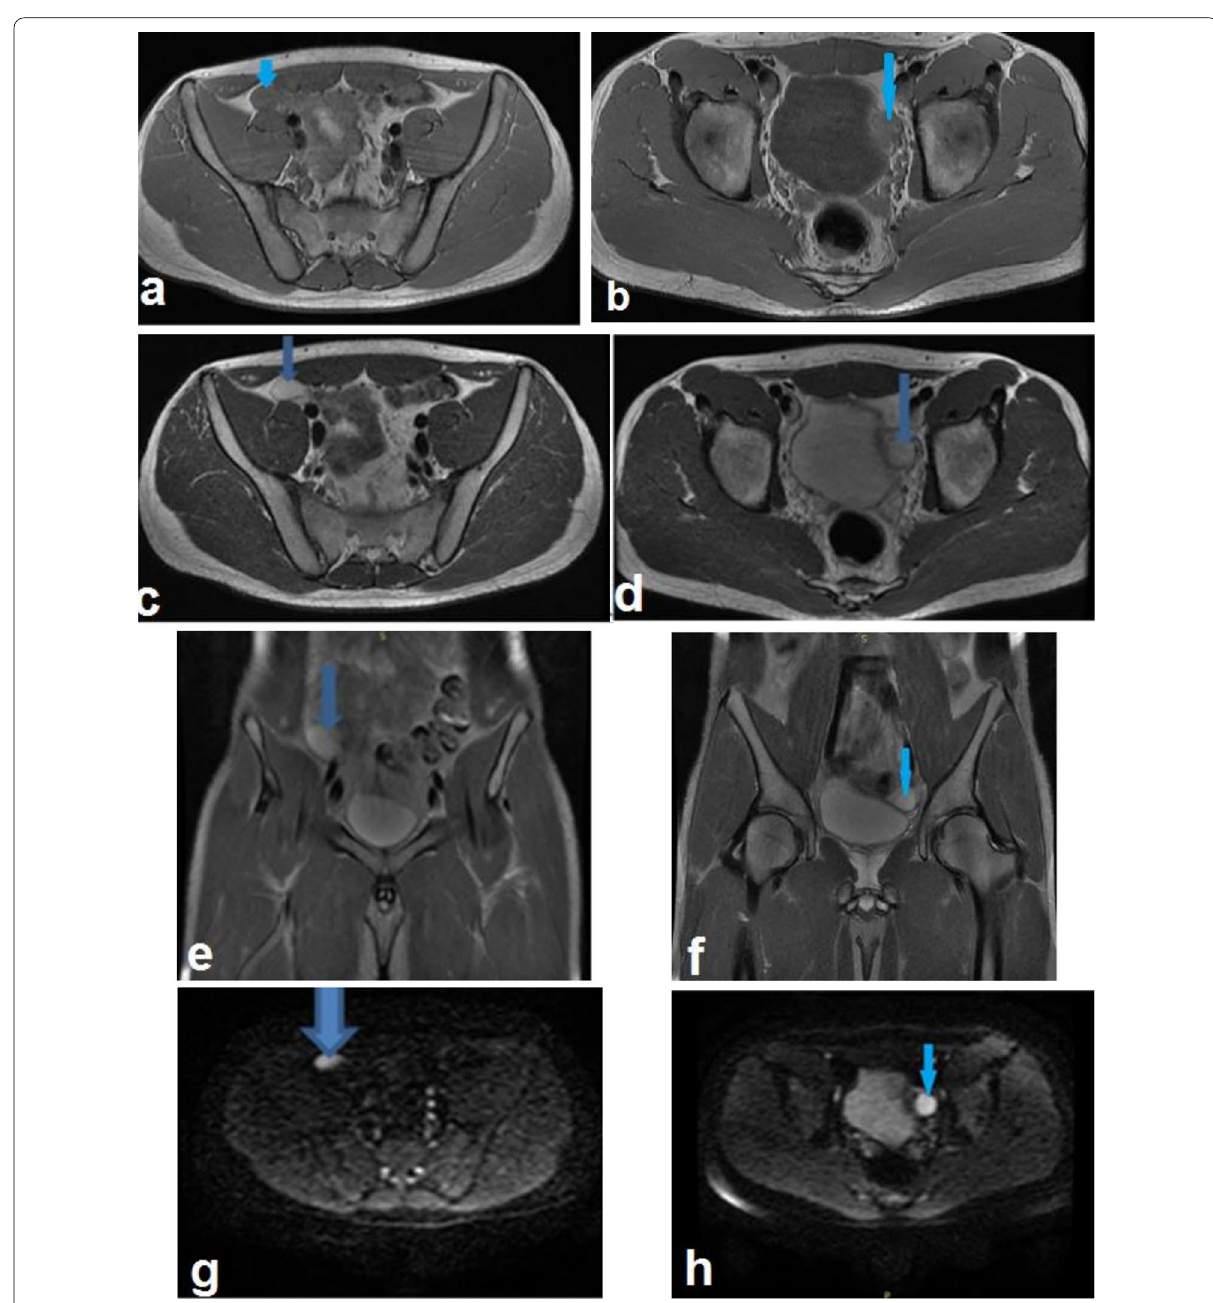
Fig. 1 A seventeen-year-old boy with bilateral non-palpable undescended testes since birth. MRI findings a , b axial T1-weighted image c , d axial T2-weighted image e , f coronal T2-weighted image showing bilateral intraabdominal undescended testes; the right one is seen in right iliac fossa and measuring about 3 1.3, and the left one is seen supravesicle and measuring 2 2 cm. They display iso-intense signal on T1WI × × and hyper-intense signal on T2WI. DWIs finding : g , h axial diffusion-weighted image showing restricted diffusion of both undescended testes b value 800 s/mm 2 . Final diagnosis : Bilateral low intraabdominal UDT. Surgical findings : Laparoscopy confirmed the MRI findings with lateral staged = orchiopexy were